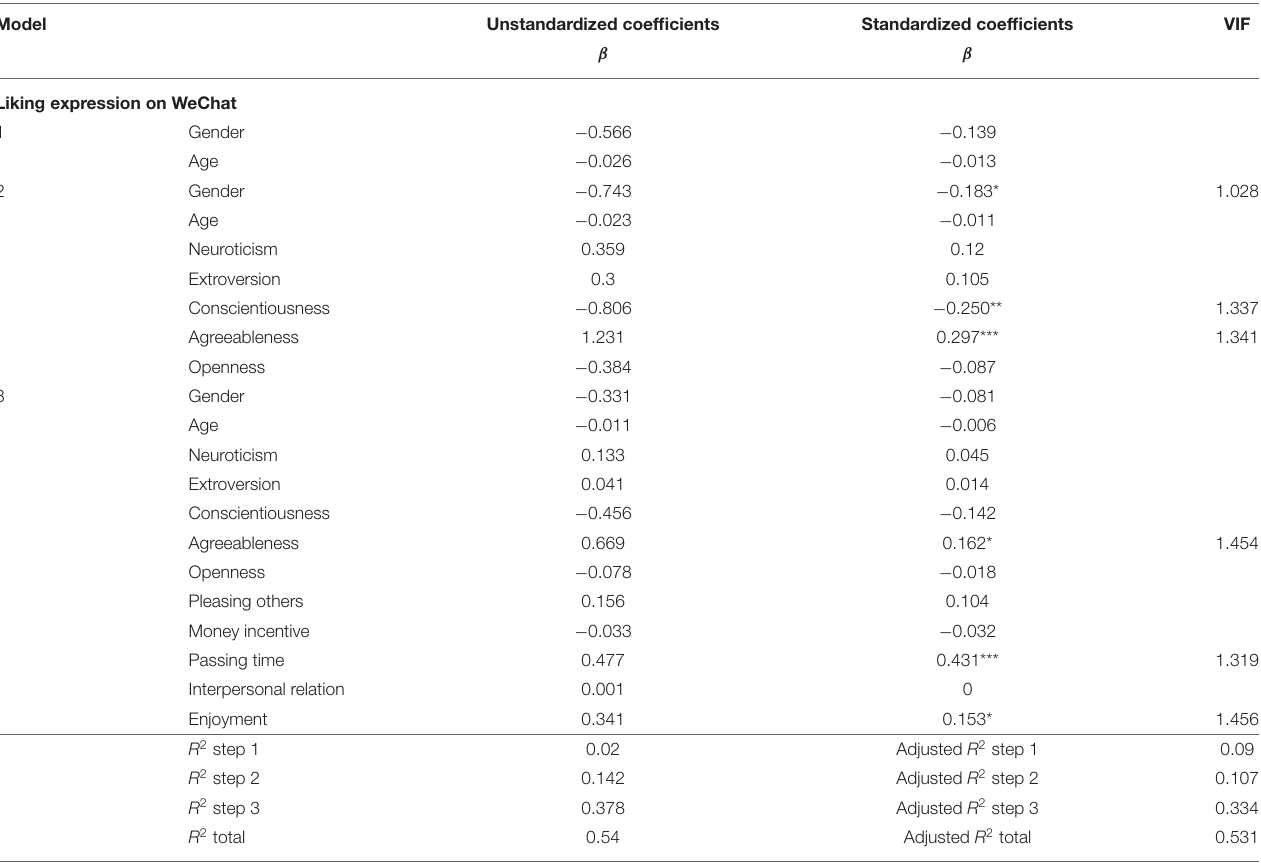
TABLE 2 | Hierarchical regression results of the contributions of age and gender (first step), personality traits (second step), and communication motives (third step) to liking expression on WeChat. Model